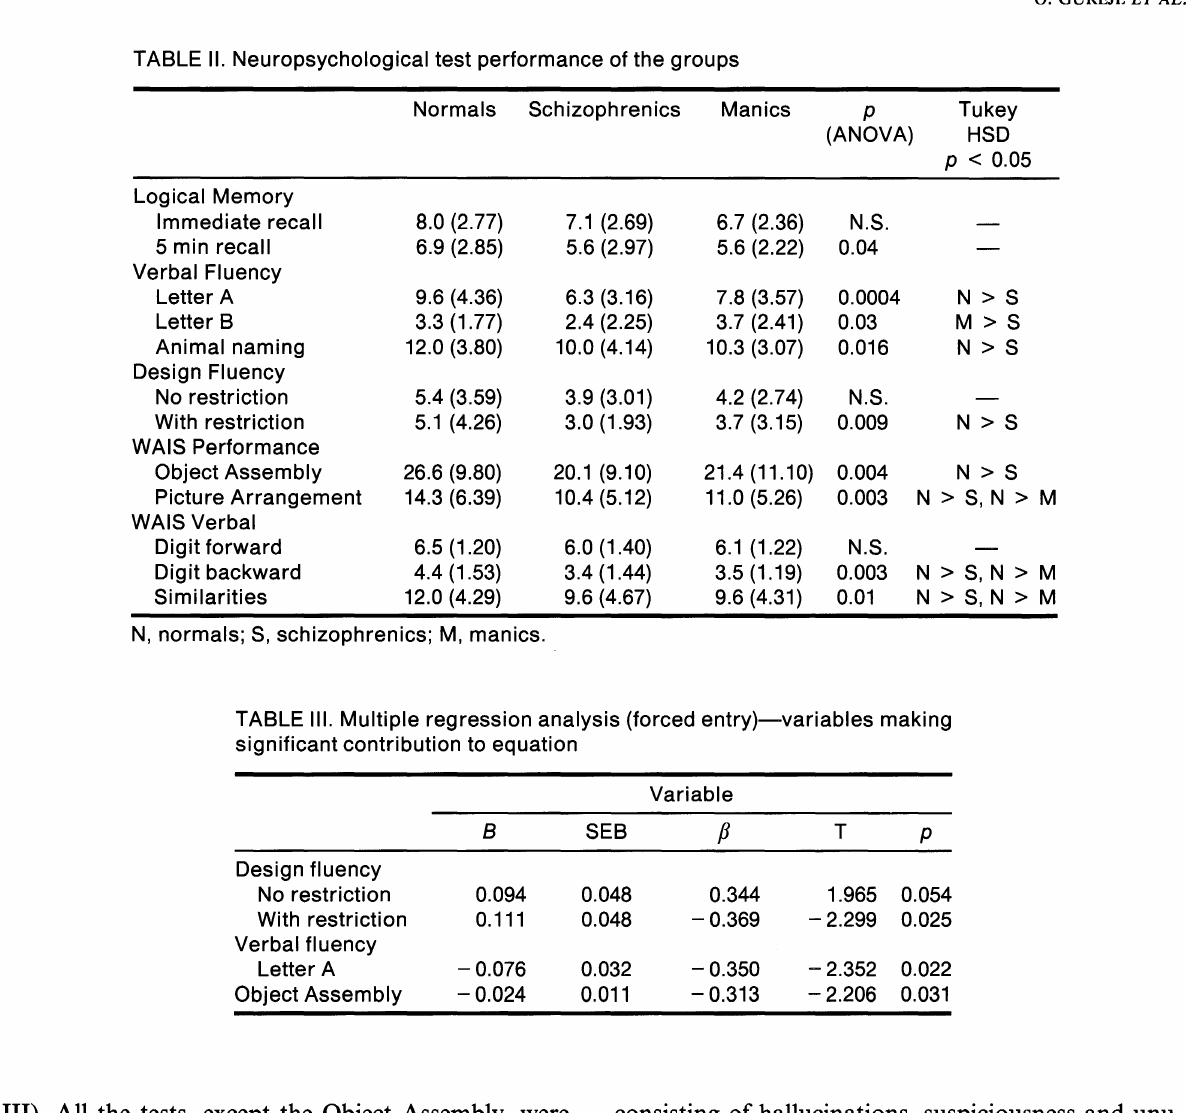
TABLE II. Neuropsychological test performance of the groups Normals